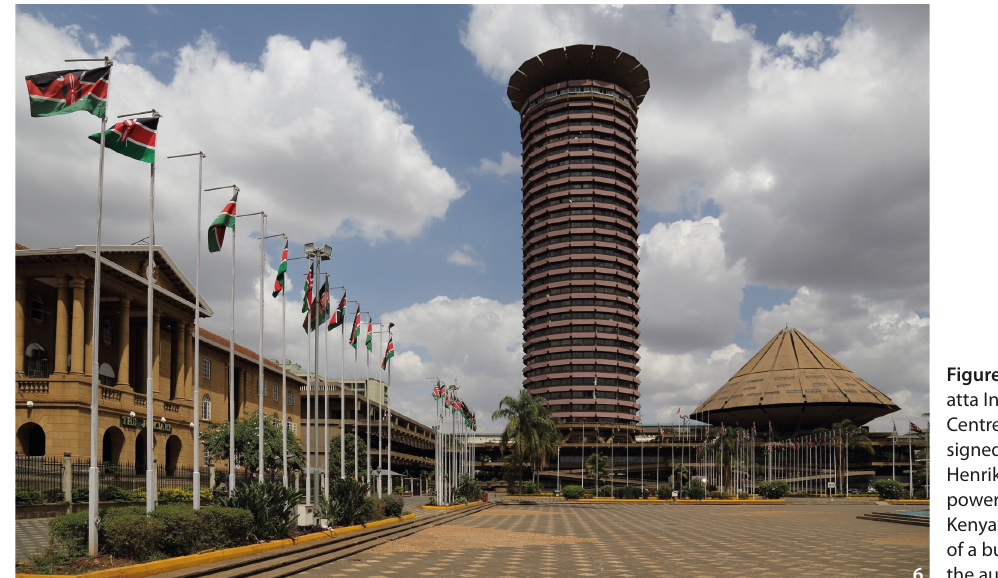
Figure 6 The 105 m-high Keny- atta International Convention Centre in Nairobi (1973), de- signed by David Mutiso and Karl Henrik Nøstvik, which became a powerful architectural symbol of Kenyan independence in an icon of a burgeoning capital (Source: the author).